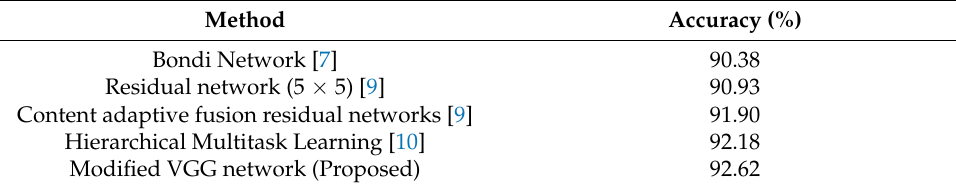
Table 5. Comparison of model-level identification accuracy of different identification